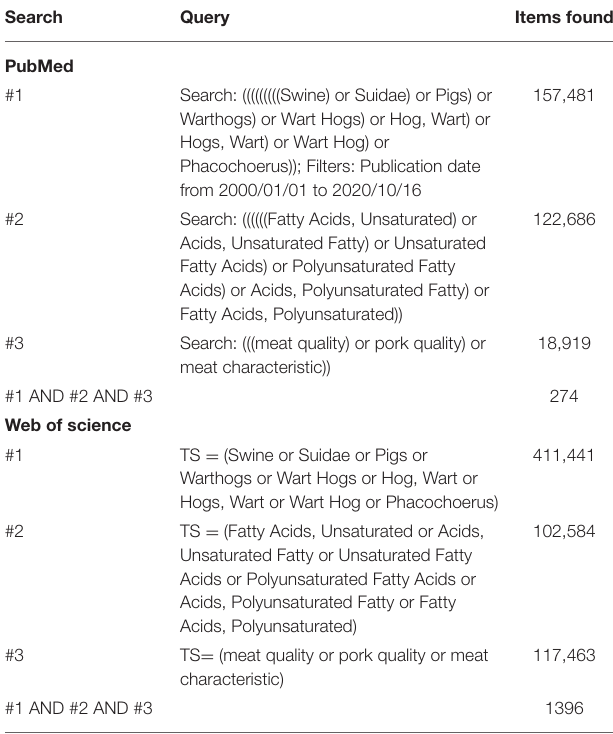
Search Query Items